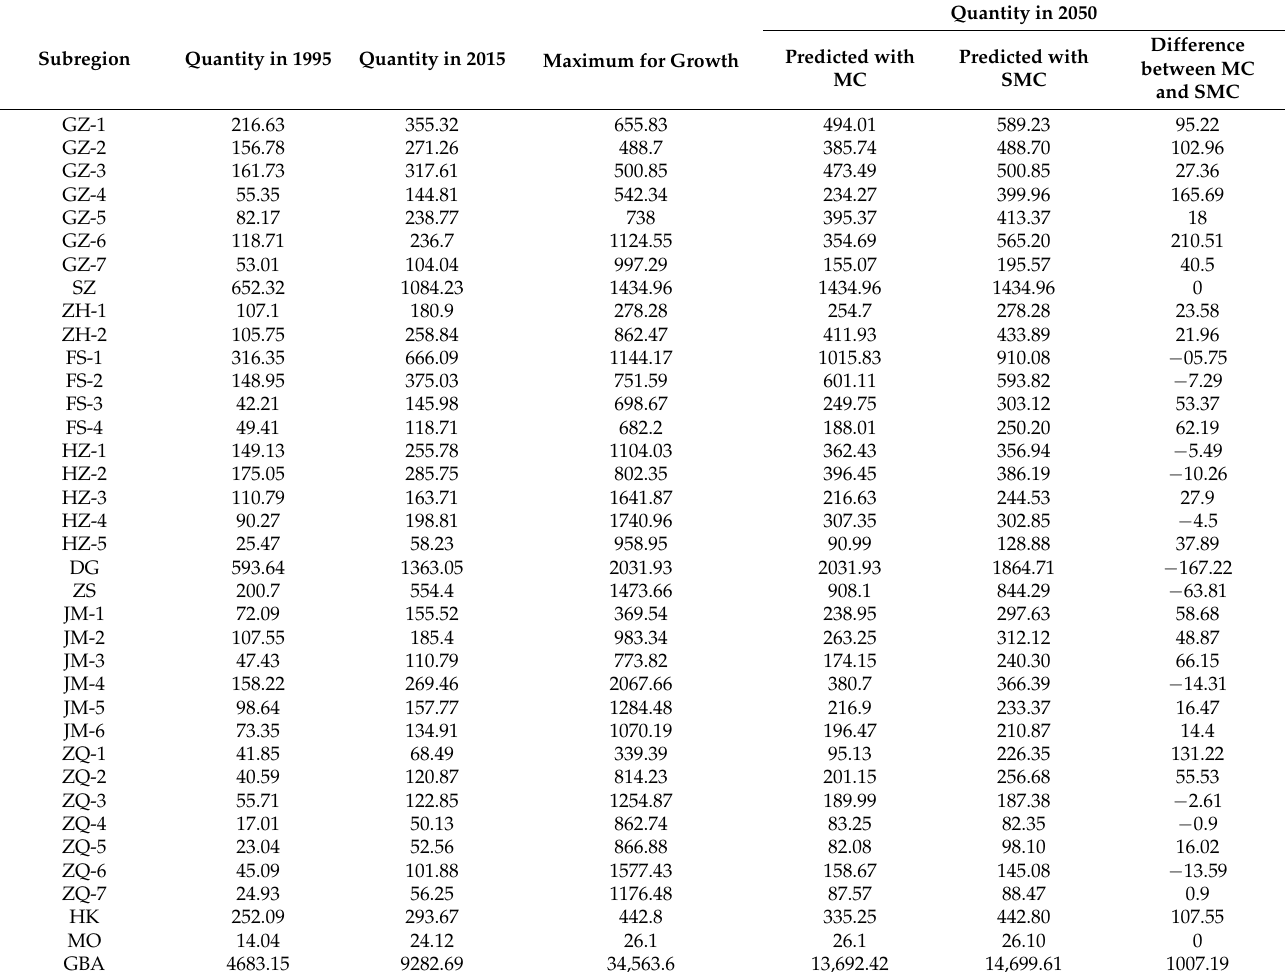
Table 2. Historical change and model predictions for the GBA (km 2